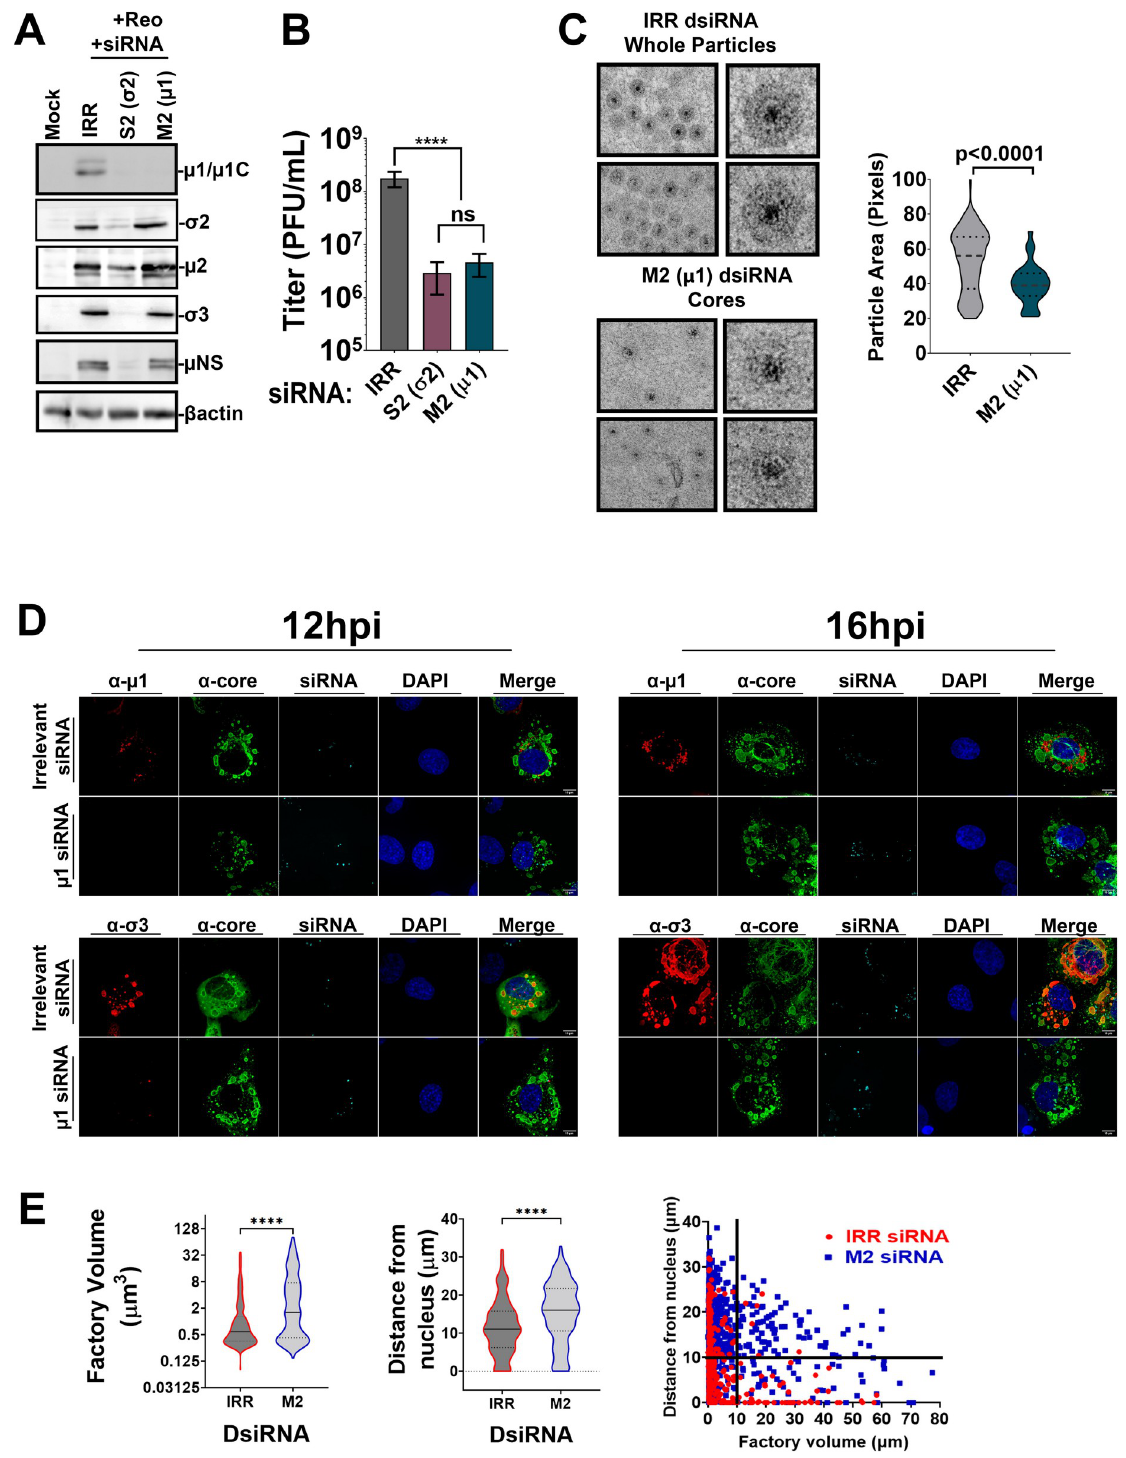
Fig 9. Outercapsid protein μ 1 promotes convergence of peripheral core-only factories into perinuclear core-plus-outercapsid factories. (A-E) Prior to infecting H1299 cells with reovirus at an MOI of 3, cells were transfected with DsiRNAs: an irrelevant control DsiRNA (IRR), a positive control DsiRNA towards an essential core protein (S2 gene; σ 2 reovirus core protein) or test condition (M2 gene; μ 1 reovirus outercapsid protein). (A) Cell lysates were subjected to SDS-PAGE followed by Western blot analysis to evaluate the extent of gene silencing. (B) Lysates from cells infected and pre-treated with DsiRNAs were collected at 18 hpi and viral titers for each condition were